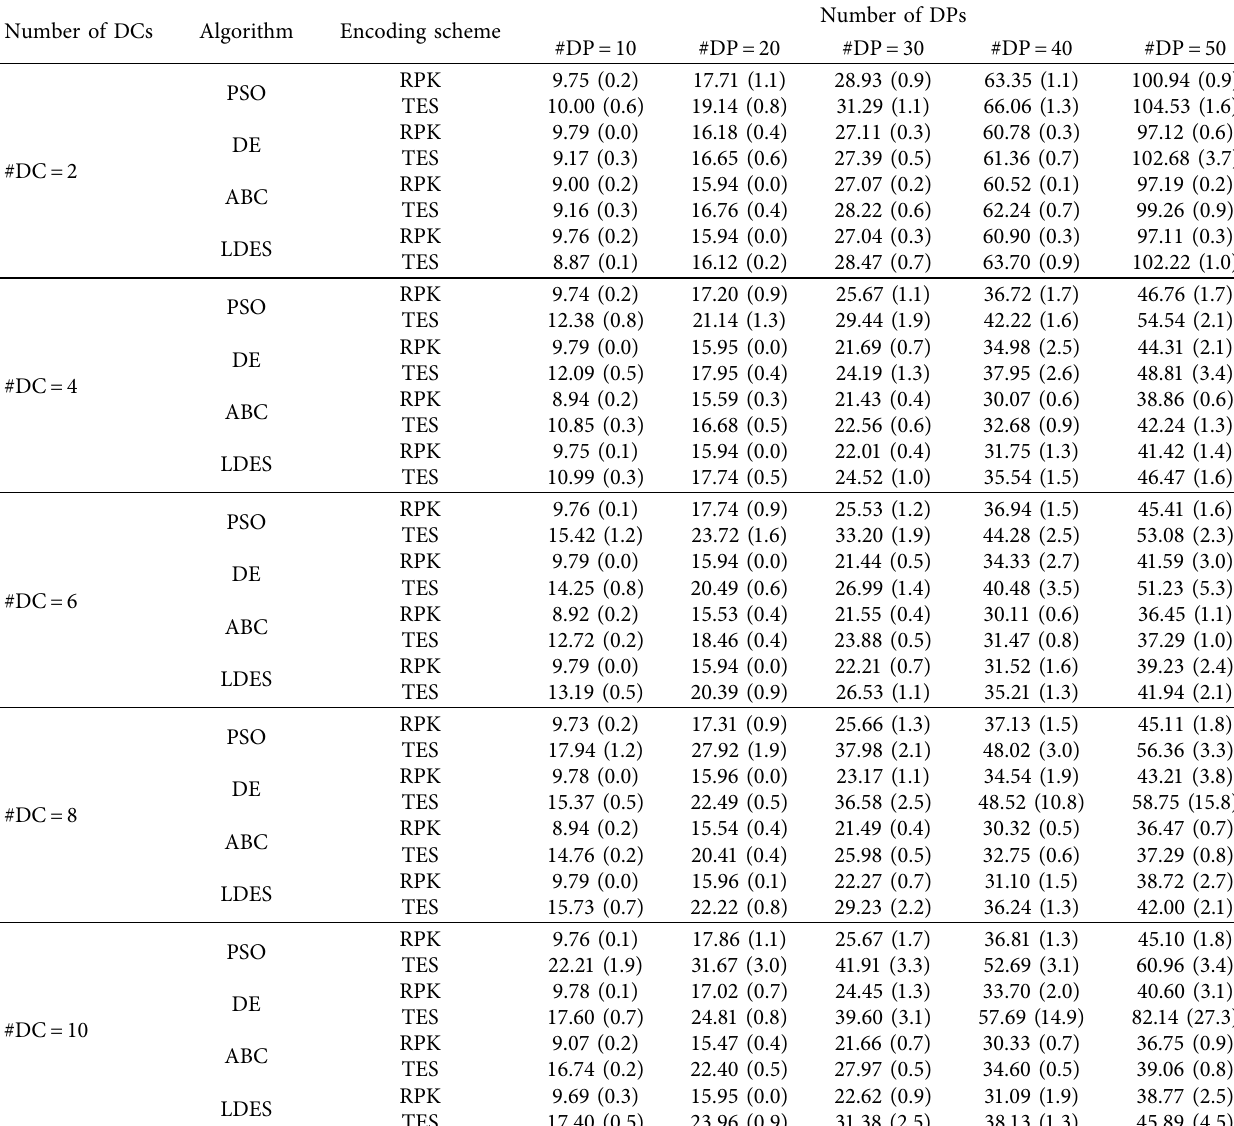
Table 5: The averaged optimal costs and standard deviations with various numbers of DCs and DPs. Number of